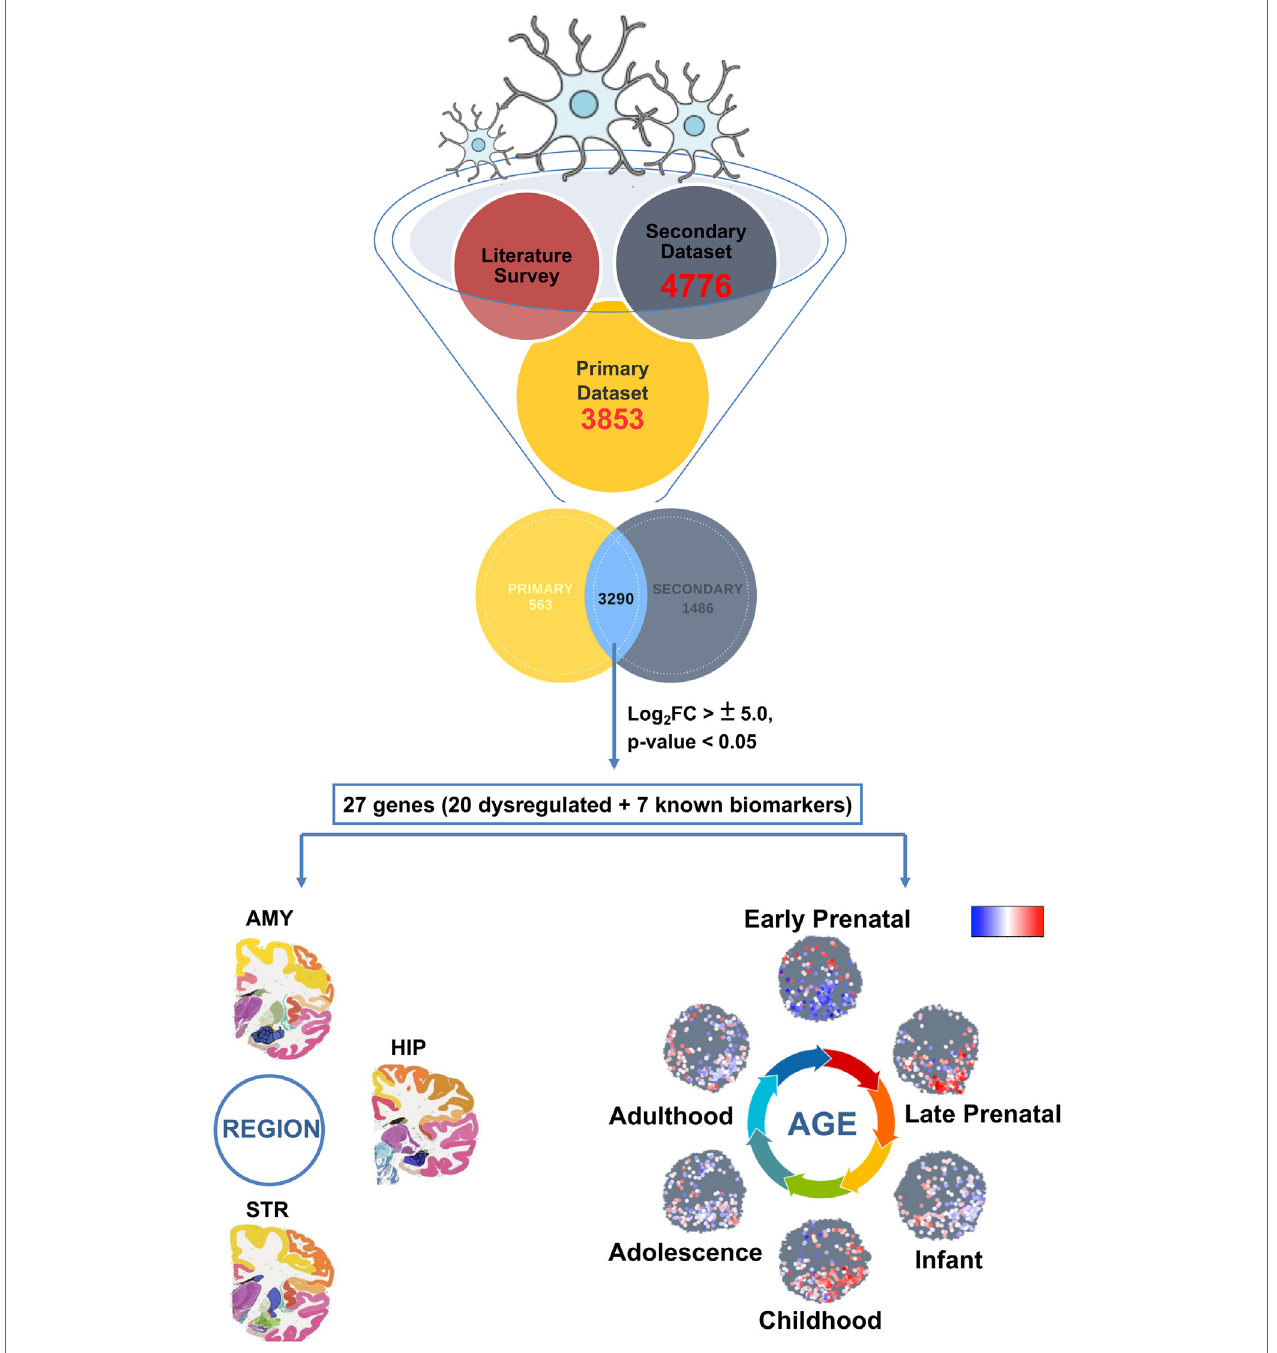
FigUre 1 | Primary strategy ( in silico approach) employed to track microglial gene expression dynamics within the developing human